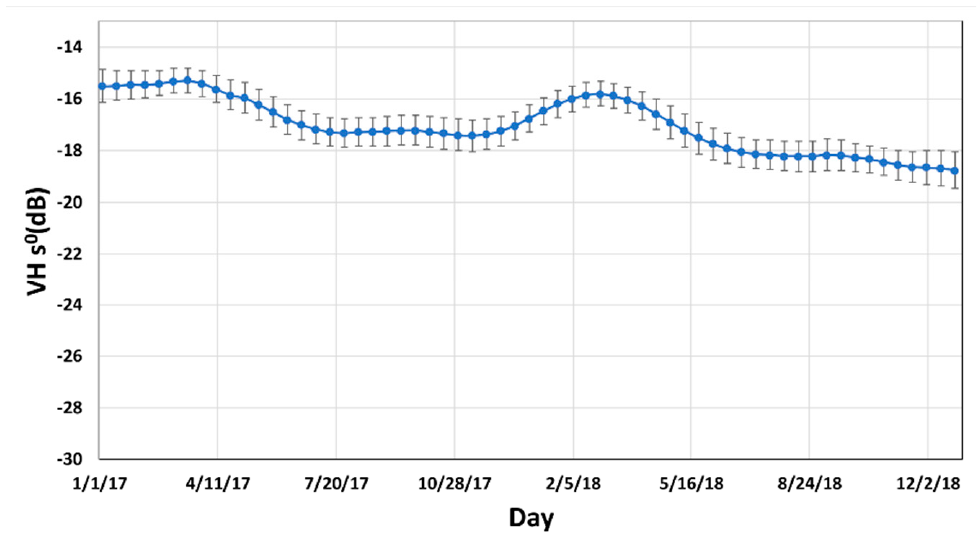
Figure 12. Behavior of the average time series with the respective standard deviation bars for the other plantations (background areas).